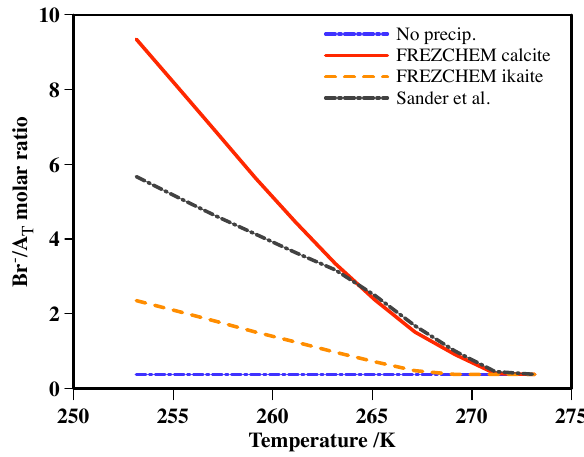
Fig. 4. The ratio of bromide to alkalinity during the freezing of sea water.